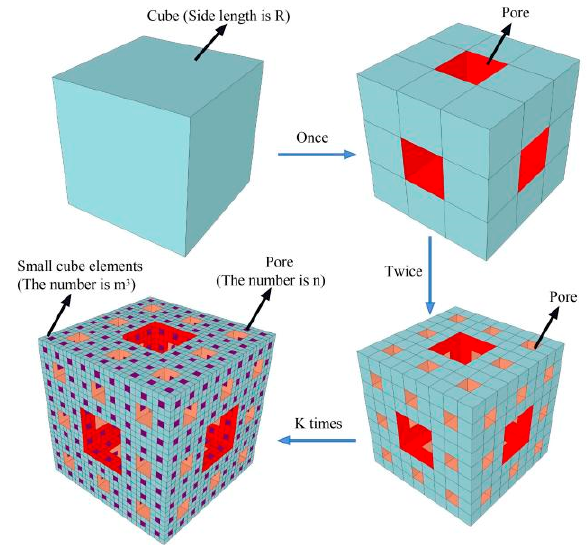
Figure 18. Menger sponge model.